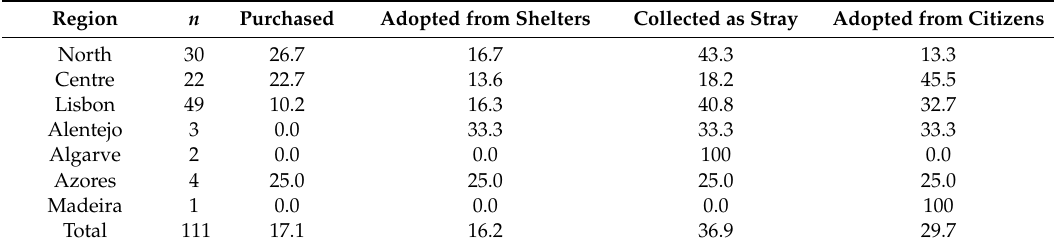
Table 2. Origin (%) of the pets owned in Portugal.